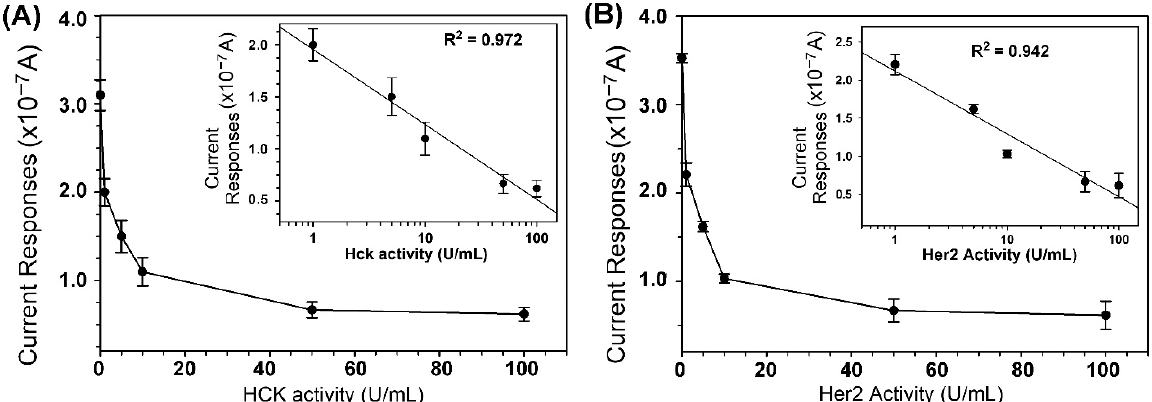
Figure 5. Phosphorylation of ELMO-Y511 and FLT3 peptides by various activities of Hck and Her2. The kinase reaction was performed in kinase reaction mixture containing 0.5 mM ATP,100 μ M ELMO-Y511 or FLT3 peptide and various activities (0, 1, 5, 10, 50, 100 U/mL) of Hck ( A ) and Her2 ( B ). Reaction was performed at 30 °C for 30 min. Subsequently, reaction mixture (2 μ L) was subjected to electrochemical measurement under the potential of − 0.2 V. The inset of each panel is the semi-log plot of the same set of data. The data is mean ± S.D of three independent experiments.